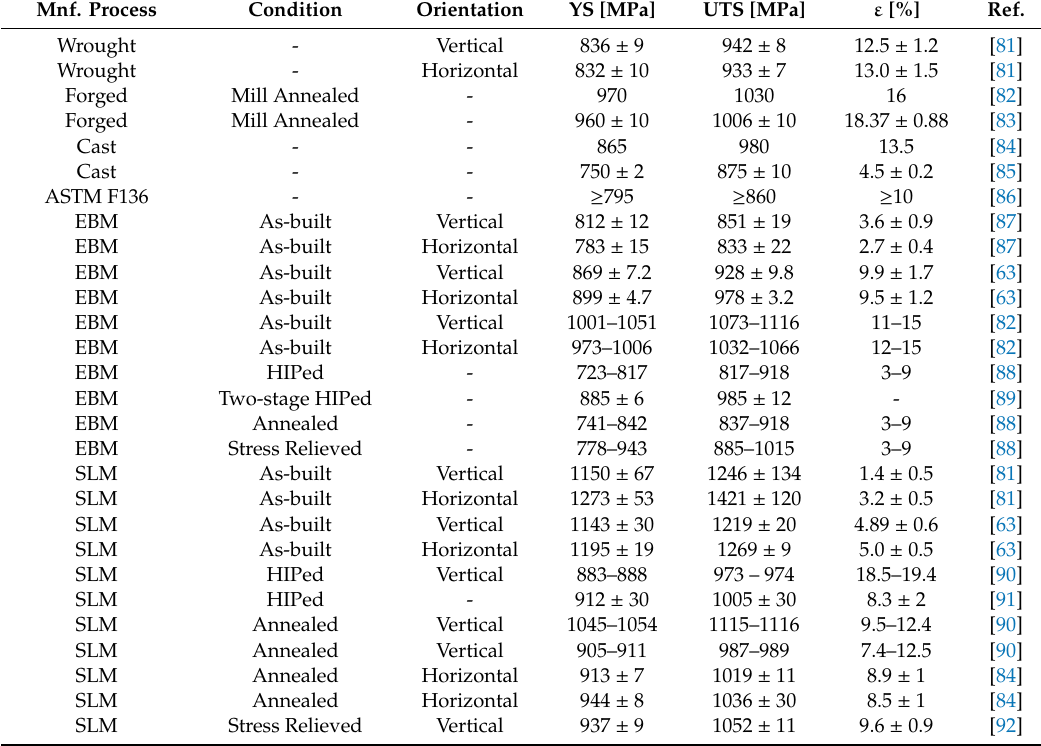
Table 3. Manufacturing process and post-treatment e ff ect on the mechanical properties of the Ti–6Al–4V